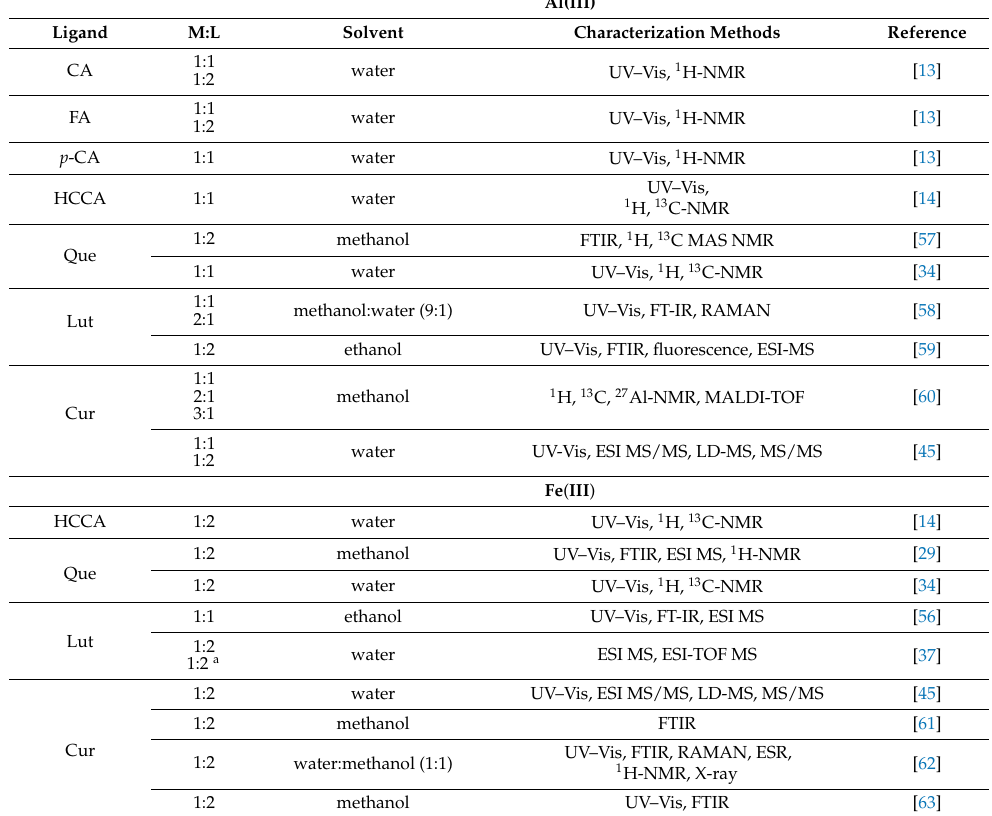
Table 3. Methods used to characterize the complexes between the selected natural antioxidants and Al(III) or Fe(III) in the reported metal to ligand (M:L) stoichiometric ratios. Al(III) Ligand Characterization Methods